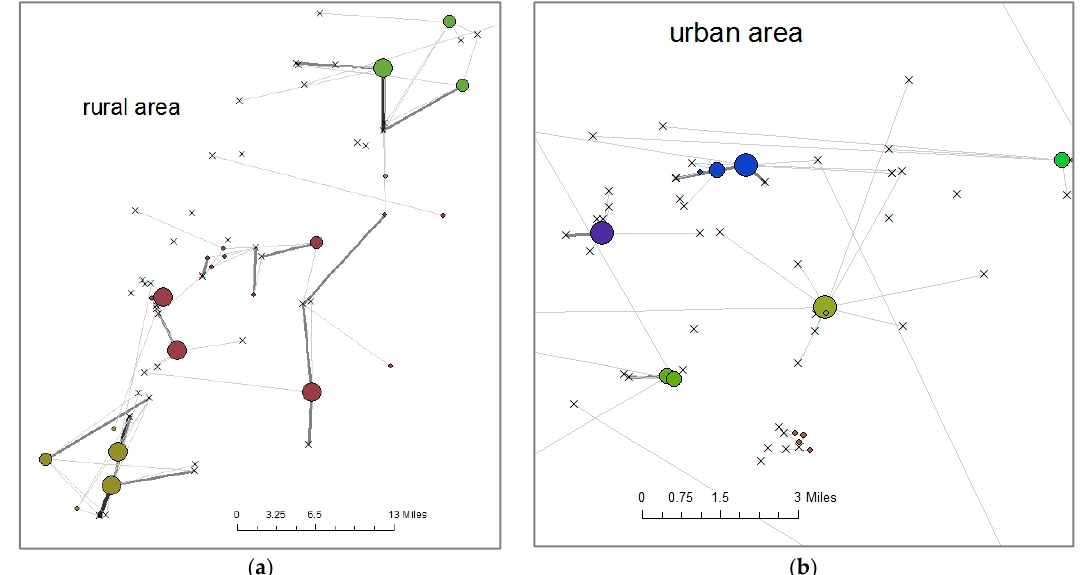
Figure 1. These figures show food shopping clusters where the small x’s represent food stores, small black dots represent the centroid of block groups where participants live and the colored circles represent food stores chosen, where larger circles indicate that more households chose that particular store and each different color indicates a distinct shopping cluster. Where x’s are connected to colored circles, one or more participants chose that store as their primary food store while x’s with no lines connecting them to colored circles represent food stores that were not chosen as the primary food store for any participants. ( a ) This figure shows three food shopping clusters within a rural area where travel distances to food stores were typically greater; ( b ) This figure shows two shopping clusters, and part of a third, in an urban area where residents have many more store choices within a smaller geographic area. Note the different geographic scales of the two maps.